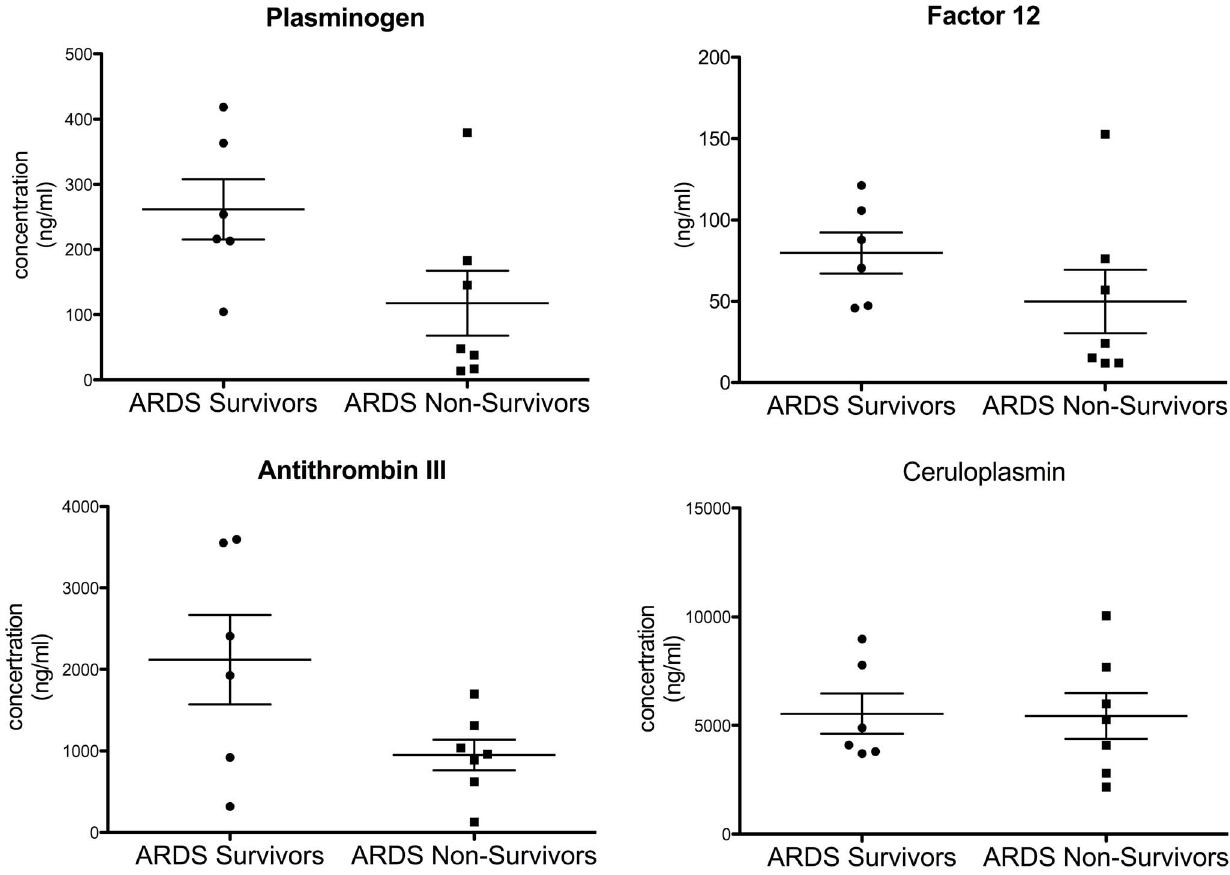
Figure 4. Protein levels of selected proteins that represent biological processes that are activated in early phase survivors (p-value plasminogen =0.06, antithrombin III=0.054, factor 12=0.2 and ceruloplasmin =0.9).